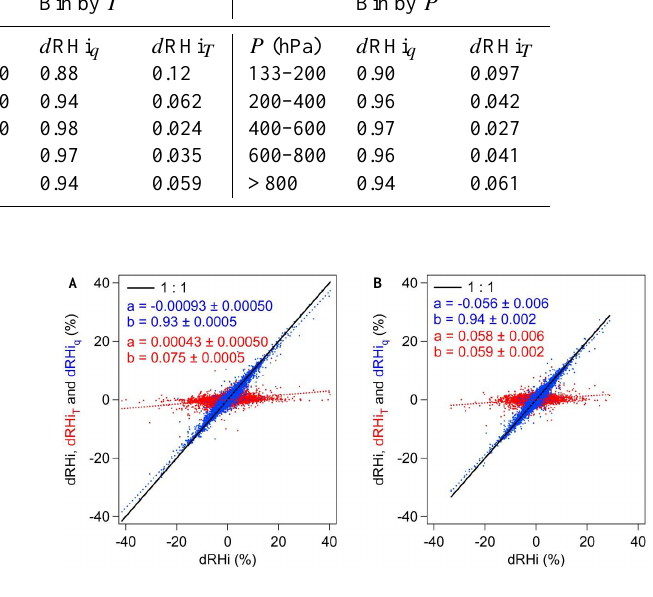
Fig. 10. RHi horizontal variability in non-ISS (subsatu- rated+saturated) and ISS conditions. (A) 1Hz d RHi analyses for non-ISS (sample size N =269334), and (B) 1Hz d RHi analy- ses for ISS ( N =17834). The large contributions of H 2 O horizontal variability to d RHi do not vary significantly between non-ISS and ISS conditions: 0.93 ± 0.0005 (non-ISS) and 0.94 ± 0.002